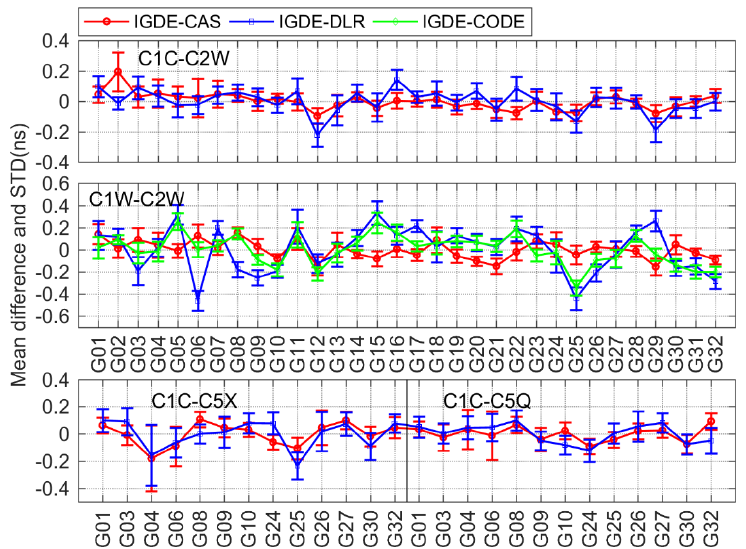
Figure 7. Mean difference and STD of GPS DCB between IGDE and MGEX products.